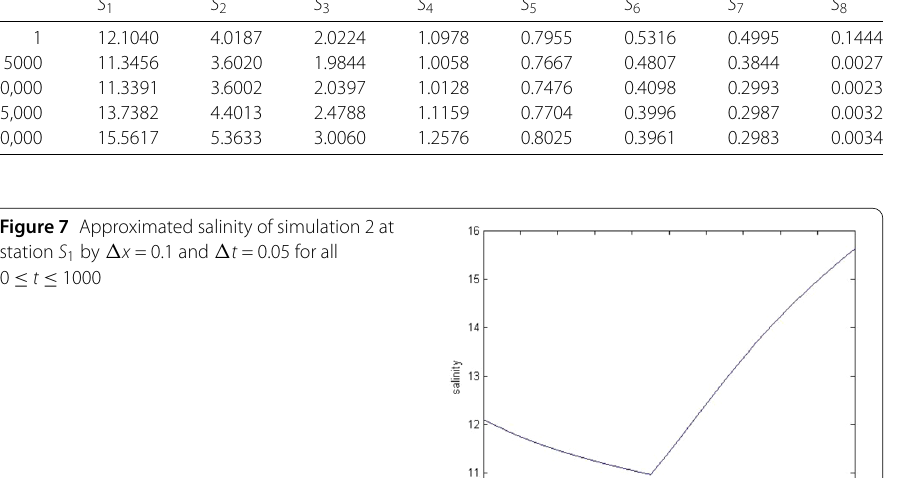
Table 7 Approximated salinity c ( x , t ) of simulation 2 for all monitoring stations